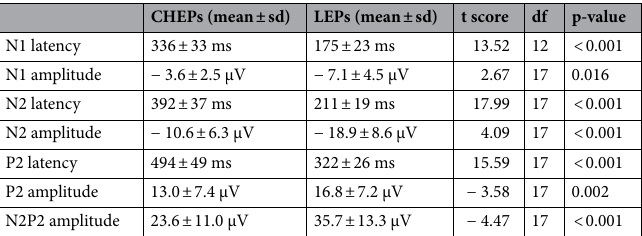
Table 1. CHEPs and LEPs baseline parameter comparison. CHEPs: contact heat evoked potentials; LEPs: laser evoked potentials; df: degree of freedom; sd: standard